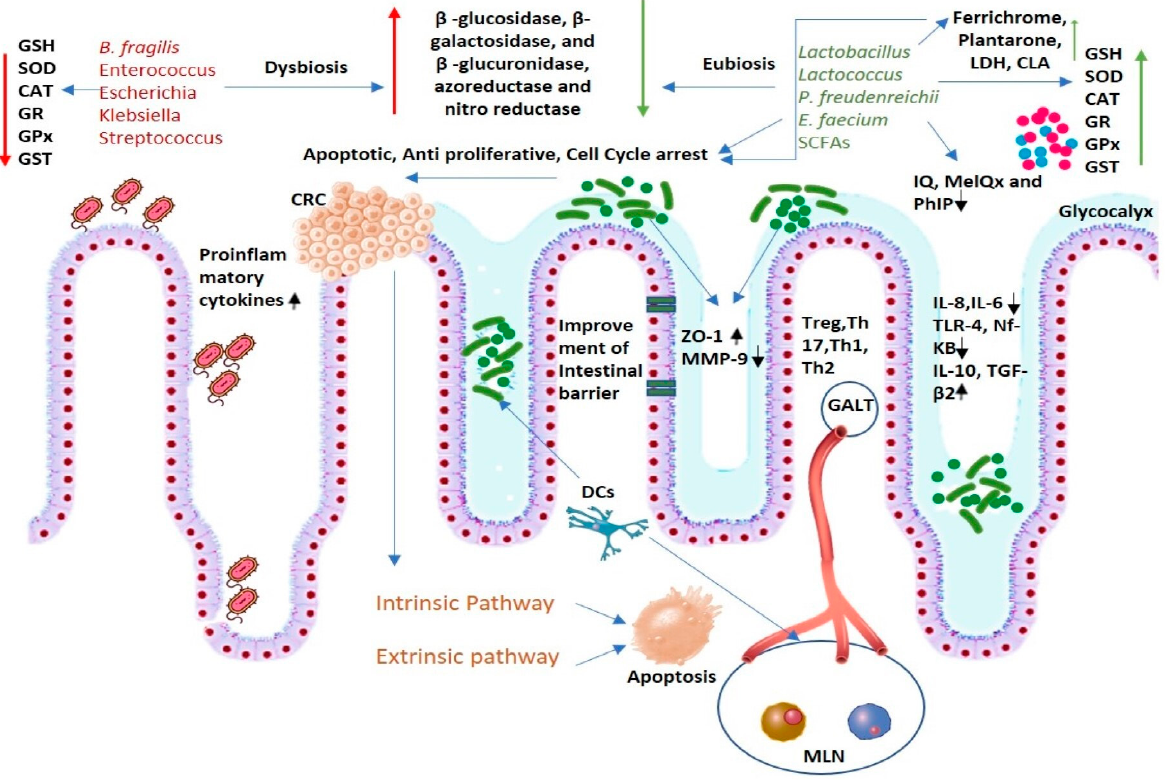
Figure 2. Different mechanisms of probiotics action in the prevention and treatment of colorectal cancer. Tumor induction, proliferation, and metastasis are often accelerated by dysbiosis conditions, which are associated with an increase in inflammation, production of enzymes that can convert different precursor compounds into carcinogens, and loss of the integrity of intestinal barrier function. Probiotics and their products, such as Short-chain fatty acids (SCFAs), exert an apoptotic, antiproliferative, and cell cycle arrest effect on cancerous cells induced by extrinsic and intrinsic apoptotic pathways. They create homeostasis and eubiotic conditions by competing with harmful pathogens and increasing tolerance of immune cells to commensal microbes by regulating the immune systems, thereby regulating the secretion of different pro-inflammatory cytokines such as IL-8 and IL-6 and anti-inflammatory cytokines such as IL-10 and TGF- β 2. They secret anticancer compounds such as ferricrome, plantarone, conjugated linoleic acid (CLA), lactate dehydrogenase (LDH) exerts an anticancer effect on tumor cells. They improve the intestinal barrier by increasing the expression of zona occludens (ZO)-1 and decreasing the expression of Matrix metalloproteinase-9 (MMP-9). They increase the expression of Reactive oxygen species scavenging enzymes such as glutathione (GSH), superoxide dismutase (SOD), catalase (CAT), glutathione reductase (GR), glutathione peroxidase (GPx), glutathione-S-transferase (GST). They can stimulate the differentiation of T-cells into Treg, Th1, Th2, and Th17, which regulate inflammation and creates homeostatic conditions. They can greatly alter the metabolism pattern of harmful microbes and reduce the number of enzymes, such as β -glucuronidase, β -glucosidase, and nitroreductase, thereby decreasing the production of carcinogenic compounds. They can directly bind and remove carcinogenic compounds such as 2-amino-1-methyl-6-phenylimidazo[4,5-b] pyridine (PhIP), 2-amino-3- methylimidazo[4,5-f] quinoline (IQ), 2-amino-3,8-dimethylimidazo[4,5-f] quinoxaline (MeIQx). (MLN: Mesenteric Lymph node; GALT: Gut-associated Lymphoid